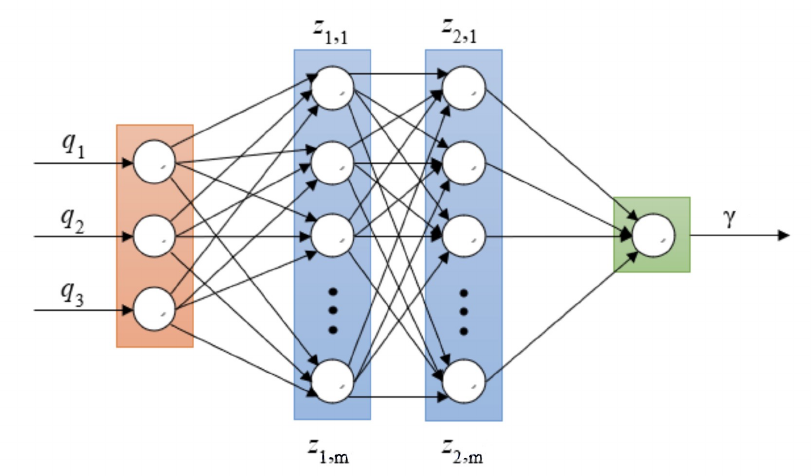
Figure 6. Construction of neural